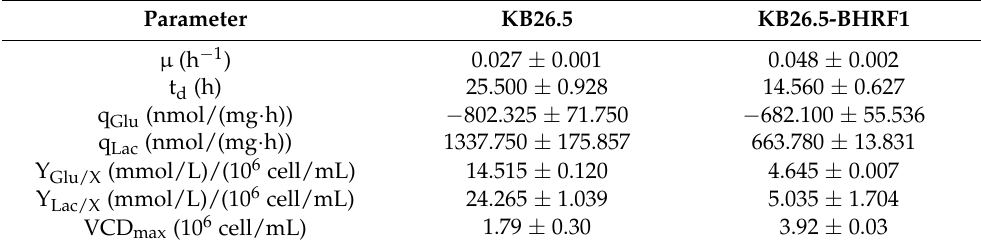
Table 2. Main physiological parameters determined for KB26.5 and KB26.5-BHRF1 in shake flask cultures. Values were calculated as the means of data obtained from duplicate